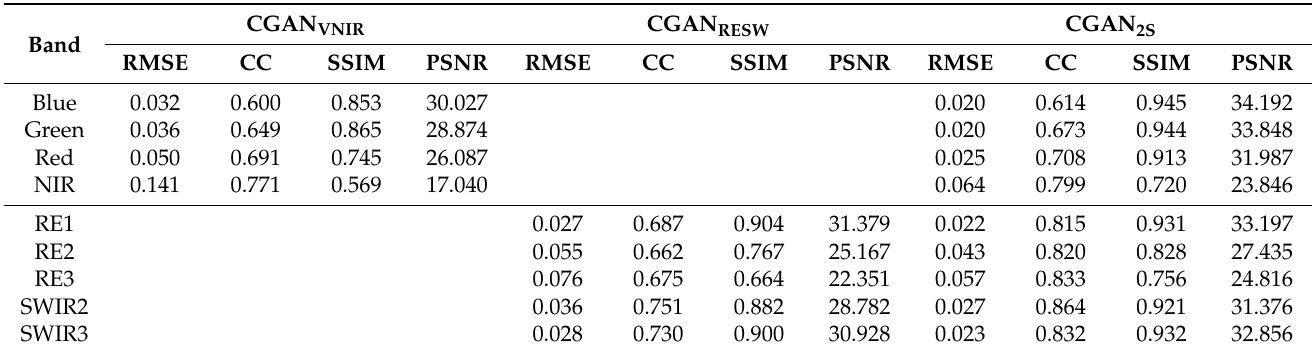
Table 9. Accuracy statistics of three CGAN models with different Sentinel-2 feature combinations (RE: red-edge; NIR: near infrared; SWIR: shortwave infrared; RMSE: root mean square error; CC: correlation coefficient; SSIM: structural similarity; PSNR: peak signal-to-noise ratio).